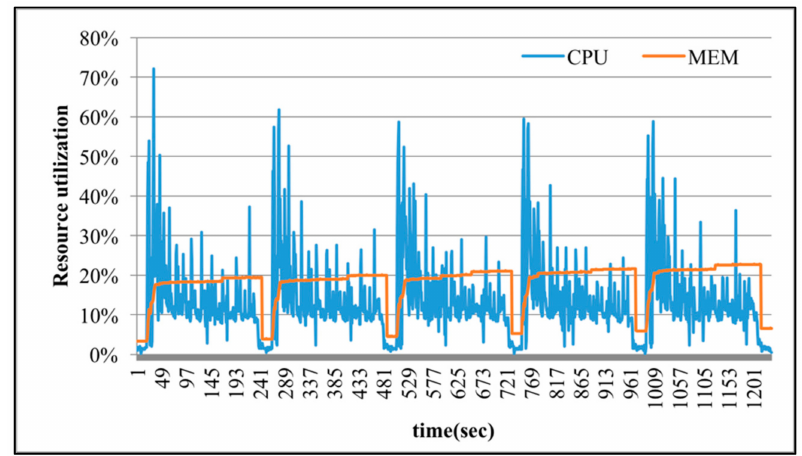
Figure 8. Resource utilization of executing SparkTC when over-commit with 16 vCPU demands.